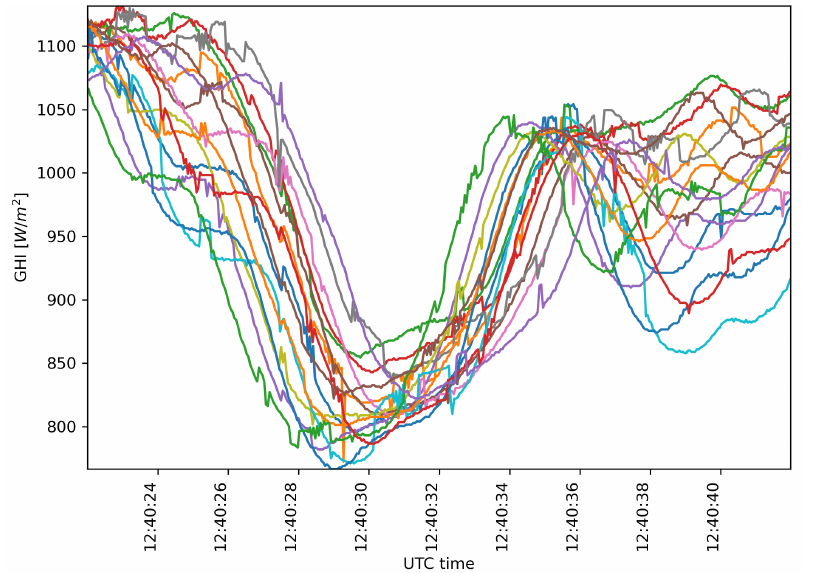
Figure 12. 20 s of 16 irradiance time series captured from WSN on 10 February 2022 starting at 12:40:22 UTC time.